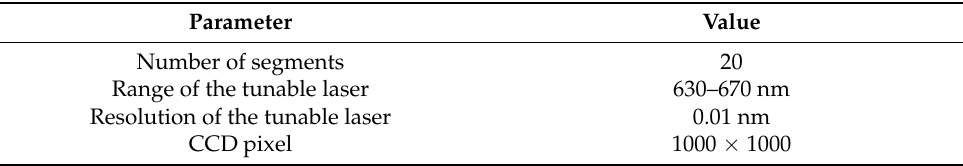
Table 1. Specifications used for the